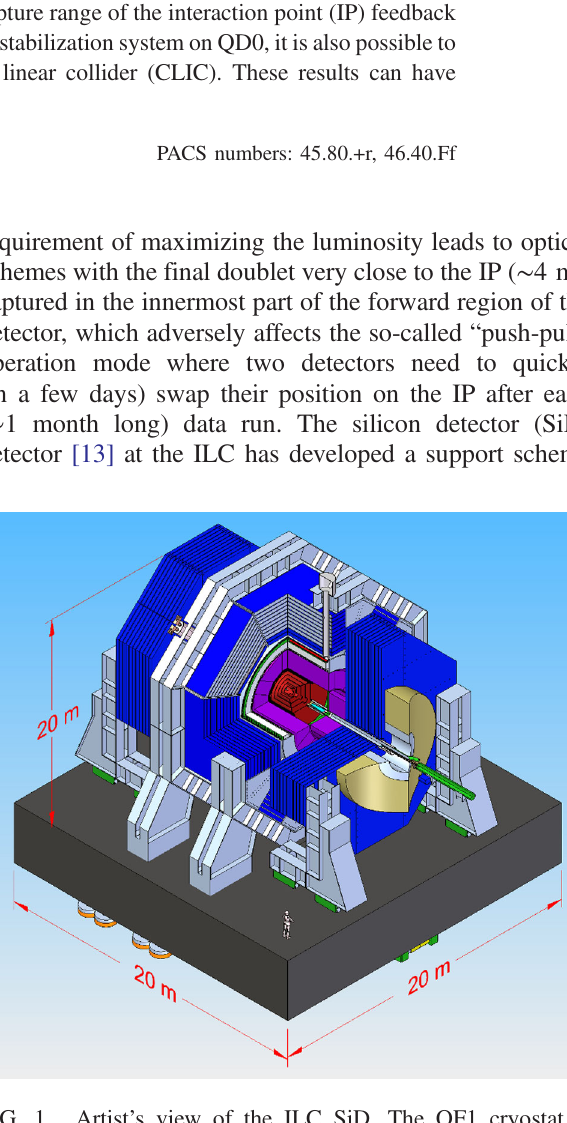
FIG. 1. Artist ’ s view of the ILC SiD. The QF1 cryostat is pictured in green and is supported by the tunnel floor (which, for clarity, is not drawn). The QD0 cryostat is contained within the gray support tube visible in the cutaway of the iron door. These two magnet assemblies are connected by a ∼ 2 m piece of beampipe housing, on the input beam leg, the feedback system ’ s stripline kicker (which appears in